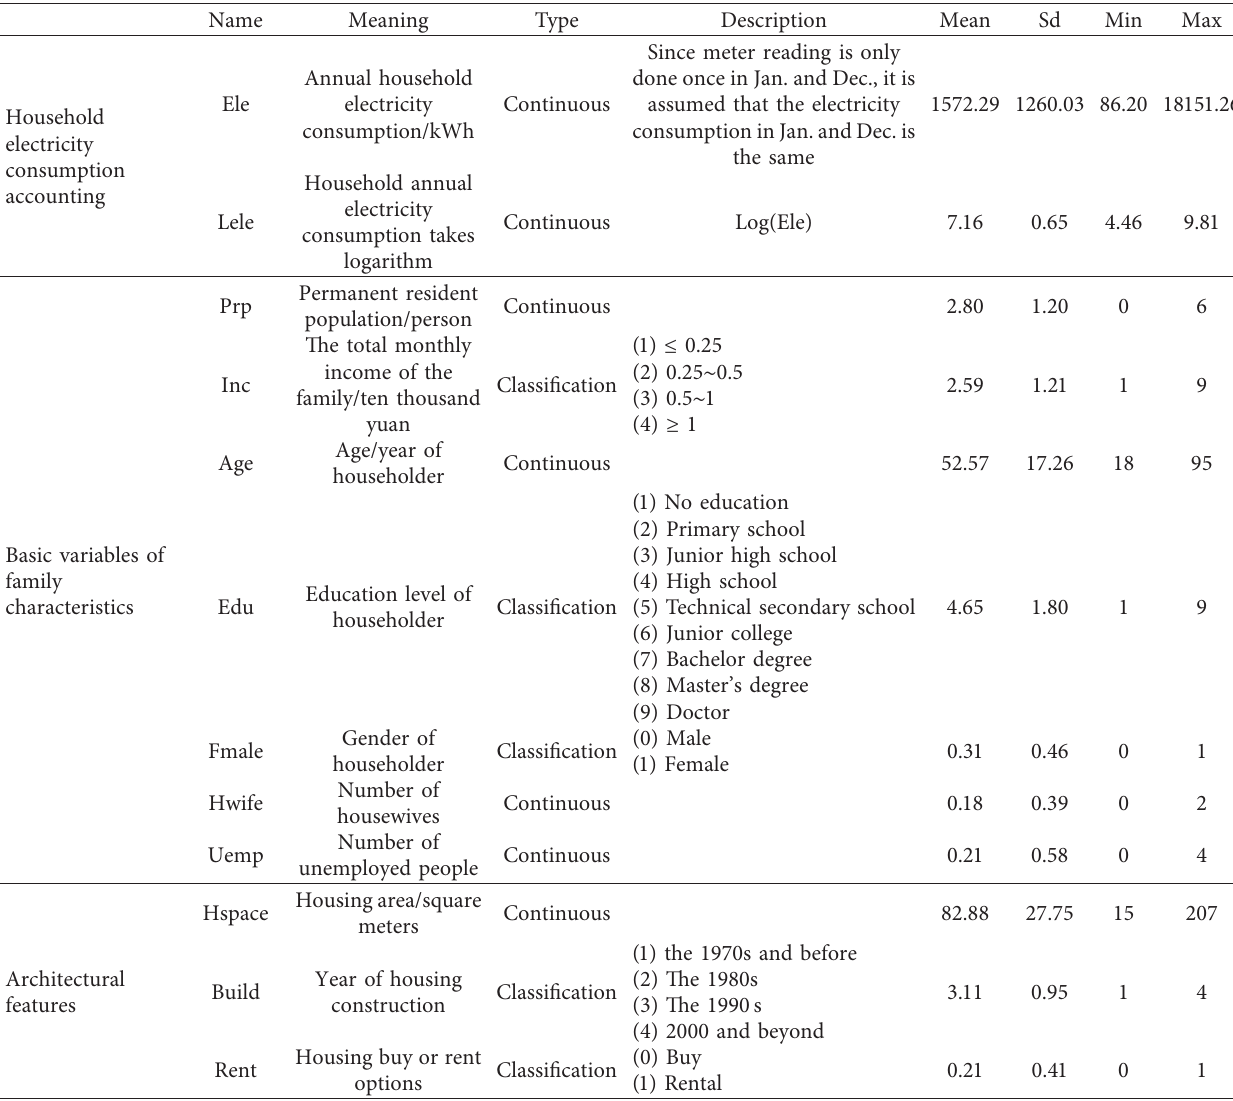
Table 1: Statistical table for description of basic variables of family